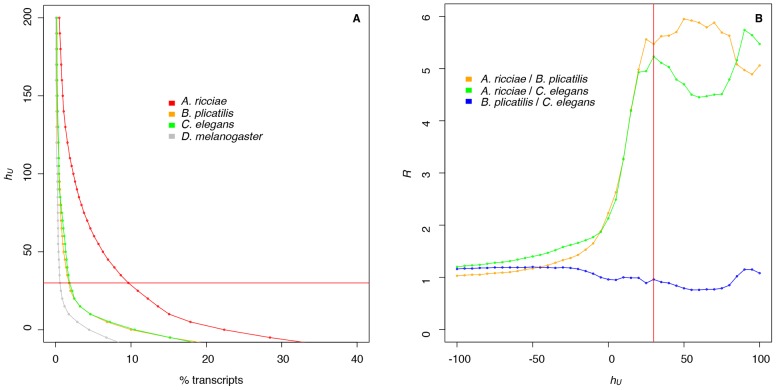
The A. ricciae transcriptome contains an unusually large proportion of sequences originating from other organisms.(A) Percentage of transcripts with HGT index hU above ordinate value for the bdelloid rotifer A. ricciae (red), the monogonont rotifer B. plicatilis (orange), the nematode C. elegans (green) and the fly D. melanogaster (grey), for the interval 0 to 200, with the horizontal red line at hU = 30. (B) The relative proportion, R, of transcripts with HGT index exceeding a given value of hU, comparing A. ricciae and B. plicatilis (orange), A. ricciae and C. elegans (green), or B. plicatilis and C. elegans (blue). The vertical red line indicates hU = 30.